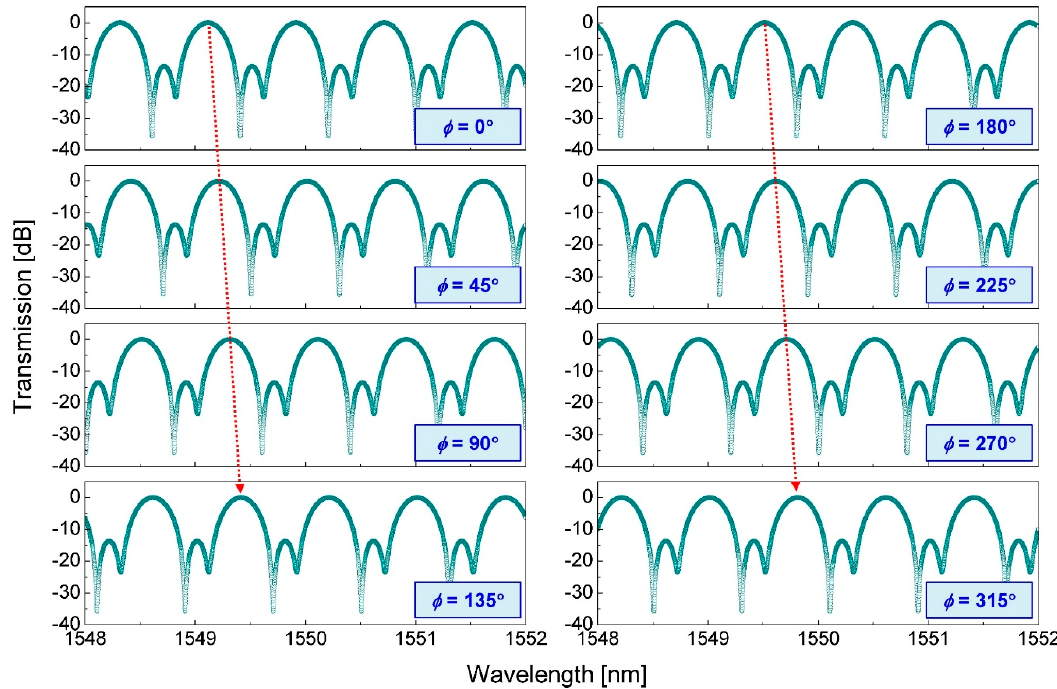
Figure 5. Calculated phase-modulated transmission spectra of GTF ( t GTF 2 ), obtained at eight WOA sets (Sets I GTF2 – VIII GTF2 ) where ϕ of t GTF 2 is chosen as 0° to 315° with an increment of 45°.